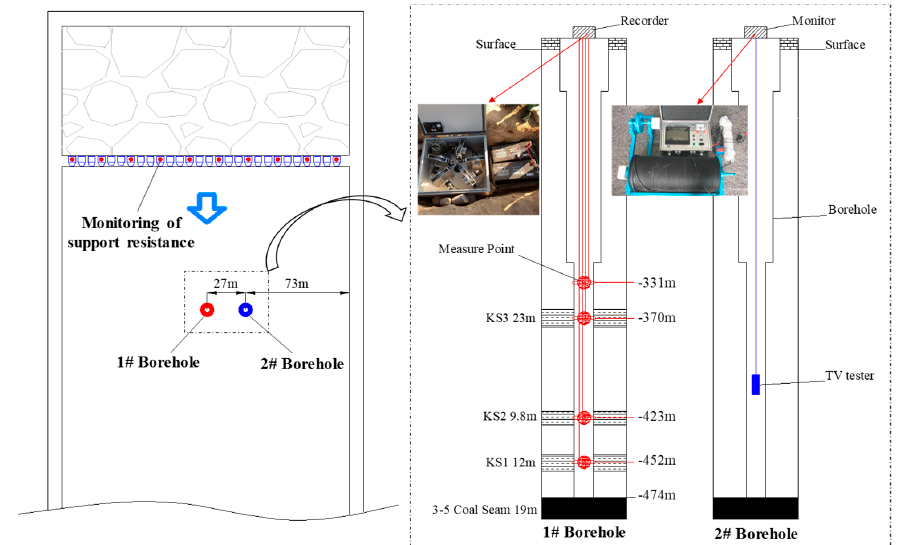
Figure 2. Measurement point layout and schema of monitoring apparatus.